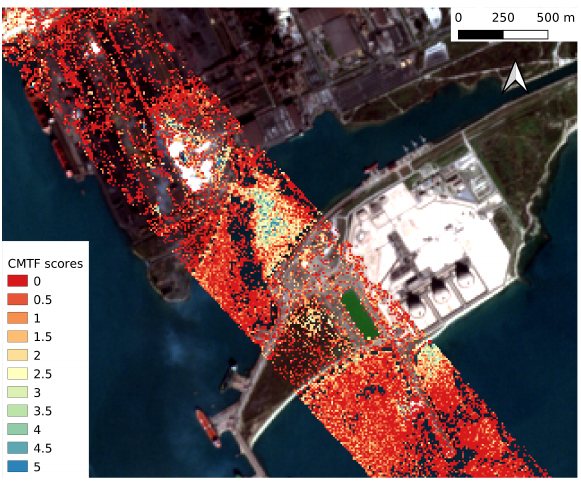
Figure 7. CTMF scores for plume spectral signatures of 0.1 µ